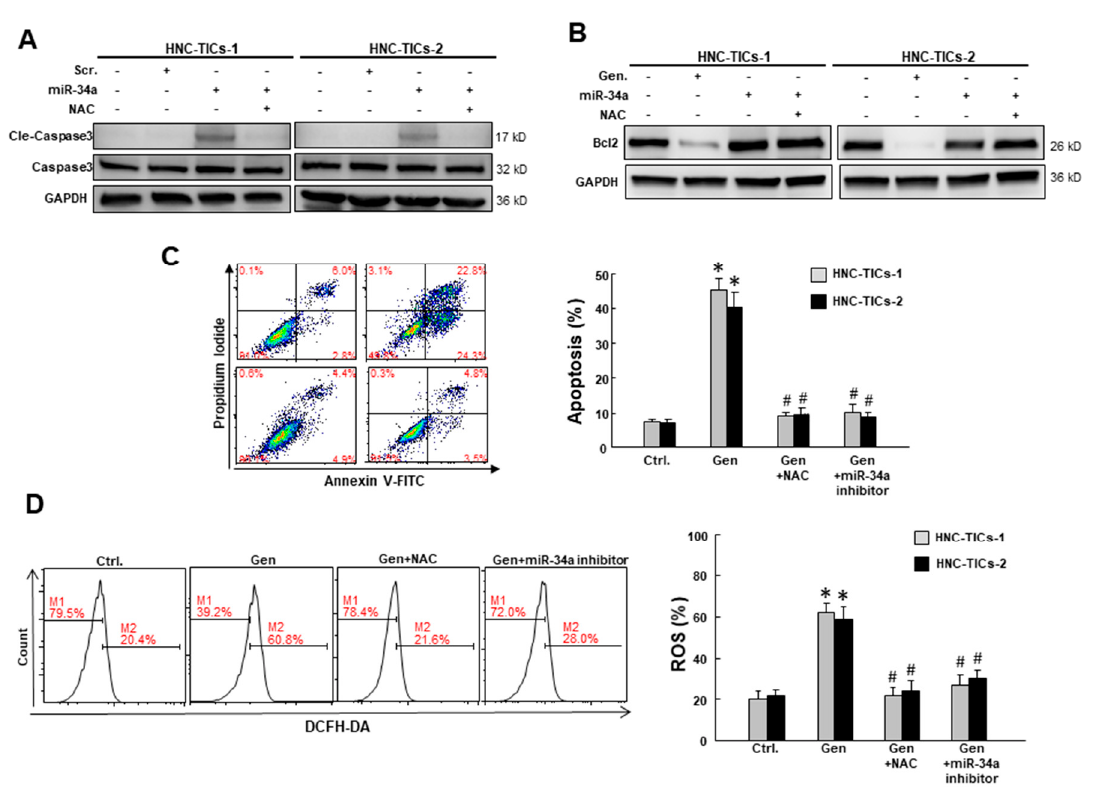
Figure 4. ( A ) The expression of the cleaved caspase-3 and caspase-3 in HNC-TICs (tumor-initiating cells of head and neck cancers) with scr. (scramble), overexpression of miR-34a or co-treatment with NAC (N-acetylcysteine) using Western blot; ( B ) The expression of Bcl-2 in HNC-TICs with treatment of genistein (Gen) (20 µ M) or combination of NAC (1 mM) or miR-34a inhibitor (1 µ M) was analyzed by Western blotting; GAPDH (glyceraldehyde-3-phosphate dehydrogenase) was used as the internal control. ( C ) Percentage of apoptotic cells and ( D ) ROS in two HNC-TICs following administration of genistein (20 µ M), genistein (20 µ M) + NAC (1 mM), and genistein (20 µ M) + miR-34a inhibitor (1 µ M) were presented using flow cytometry. * p < 0.05 compared to control group. # p < 0.05 compared to genistein only group.